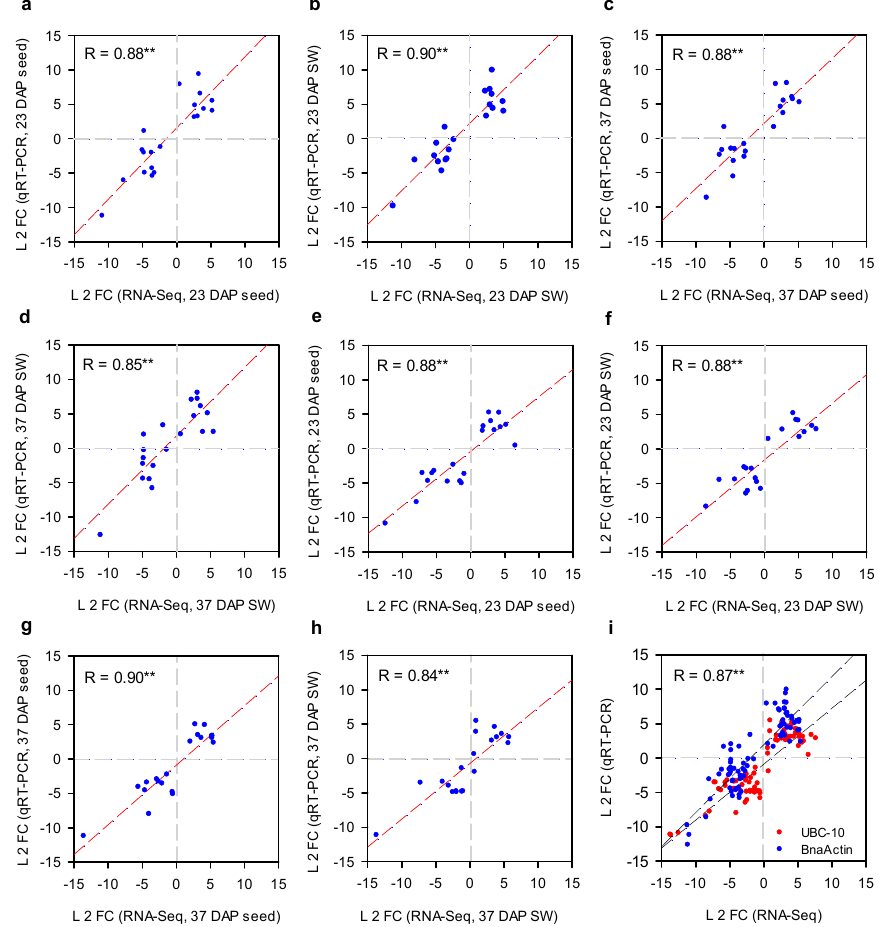
Figure 6. Validation of RNA sequencing data by using quantitative real-time polymerase chain reaction (qRT-PCR). Expression abundance of 20 randomly selected differentially expressed genes in seed and silique wall samples 23 and 37 days after pollination is presented as the ratio of HOC and LOC lines. B. napus actin and UBC-10 genes were used as an internal control for data normalization. Normalized expression (2 −Δ Ct ) in 1L99 samples was divided by normalized expression in 1L363 samples and log2 transformed. Data represent mean values ± SE of three biological replicates and two technical replicates of each sample. The correlation coefficient (R) was calculated for comparison. BnaActin: ( a ) 23 DAP seed, ( b ) 23 DAP SW, ( c ) 37 DAP seed, ( d ) 37 DAP SW, UBC-10, ( e ) 23 DAP seed, ( f ) 23 DAP SW, ( g ) 37 DAP seed, ( h ) 37 DAP SW, ( i ) collective correlation coefficient of both stages and tissues together. ** Significant at p < 0.01. L 2 FC, log2 fold